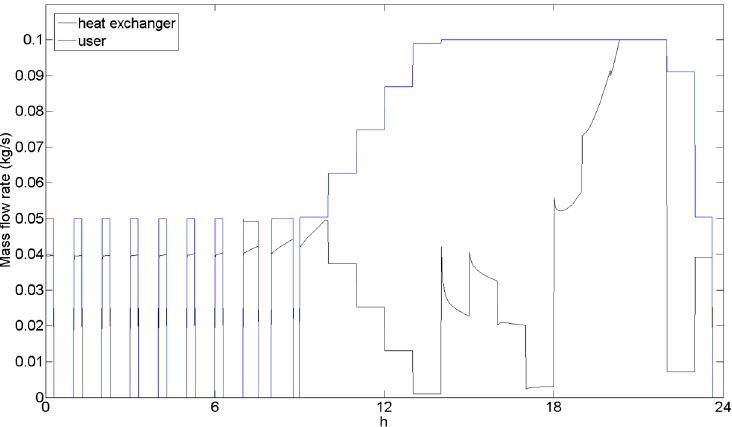
Figure 11. HTF mass flow rate through the water tank heat exchanger and the user.